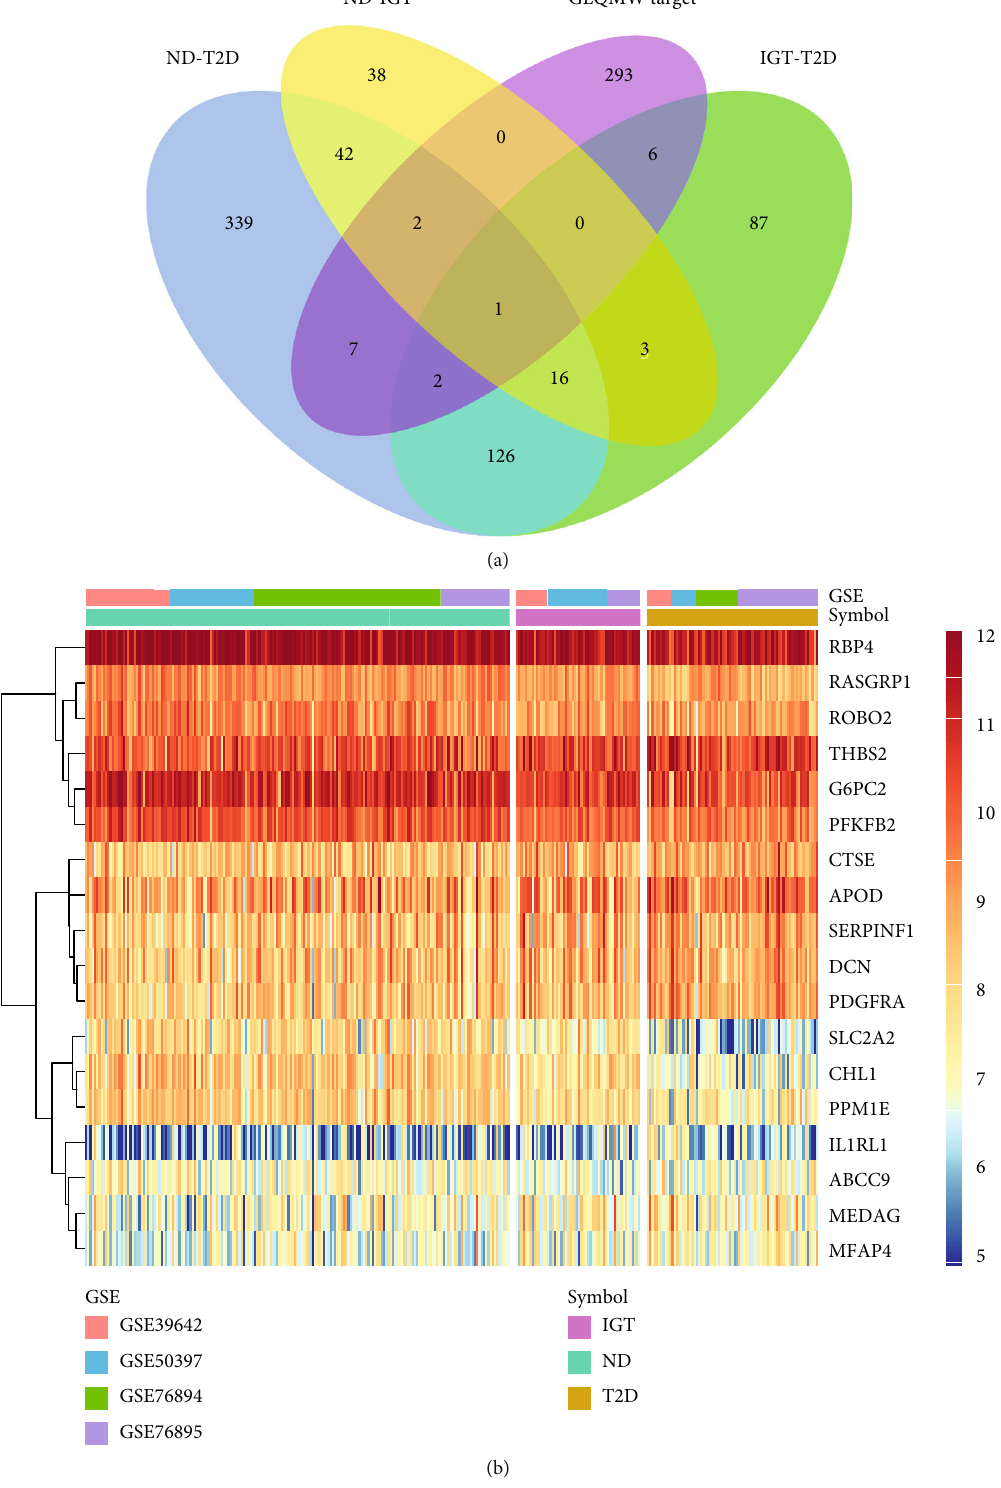
Figure 9: Venn diagram and heatmap of intersecting DEGs between process of ND-IGT-T2D and GLQMW target proteins. (a) Venn plots showing the intersecting targets between common DEGs in ND-IGT-T2D and GLQMW target proteins. (b) The expression level of intersecting DEGs in ND, IGT, and